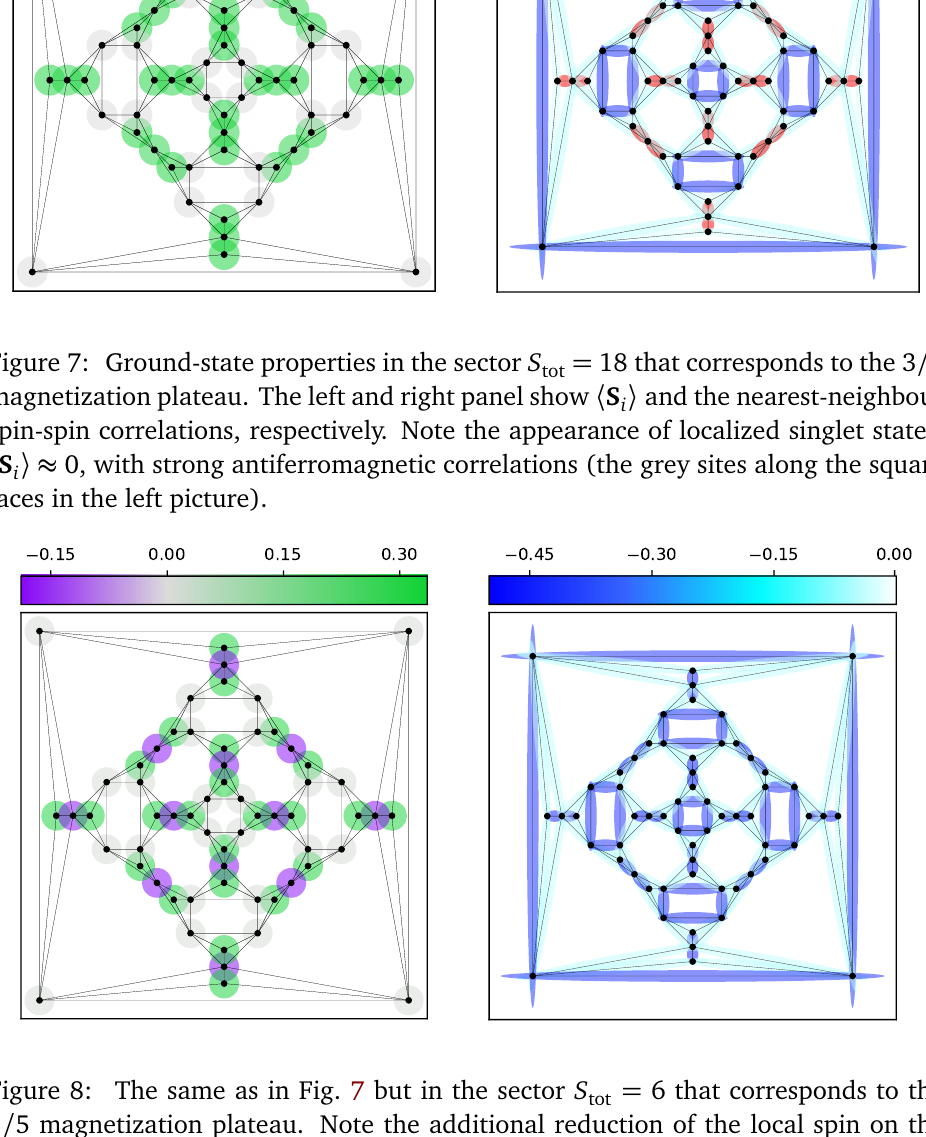
Figure 8: The same as in Fig. 7 but in the sector S 1 / 5 magnetization plateau. Note the additional reduction of the local spin on the 12 sites between the hexagon faces (purple). Correspondingly, the 3-site clusters between the squares now acquire a total spin of 1 / 2 and strong antiferromagnetic